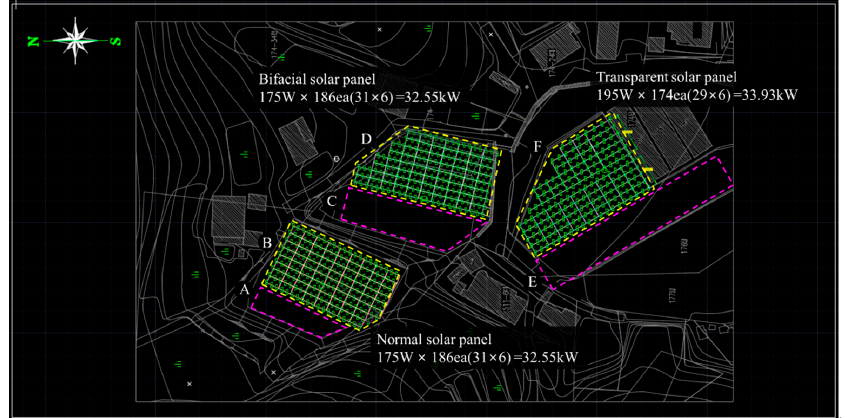
Figure 6. Sections of 3 types of installed panels. A, normal control site; B, normal solar-panel site; C, bifacial control site; D, bifacial solar-panel site; E, transparent control site; and F, transparent solar-panel site.